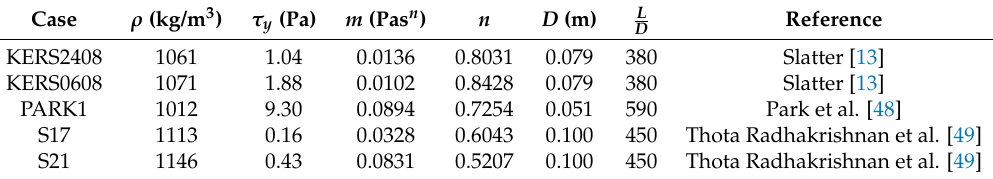
Table 1. The test cases considered for this article. The first two are from Slatter [13], PARK 1 is from Park et al. [48], and the last two belong to experimental data supplied by the co-authors [49].